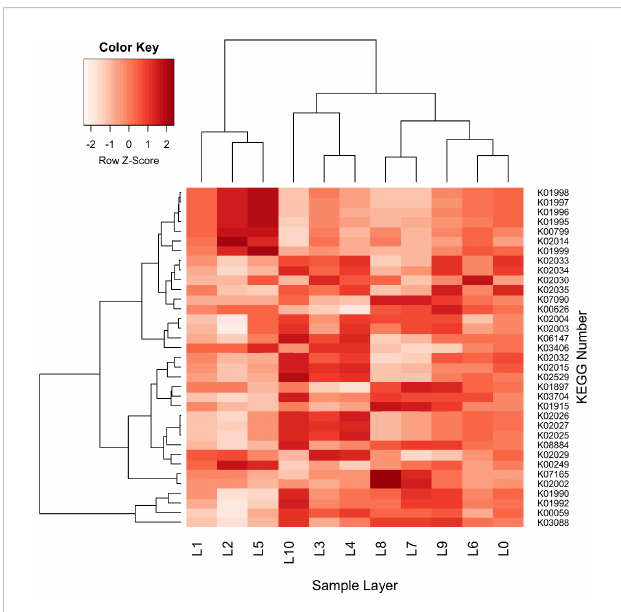
FIGURE 6 Heatmap showing most abundant likely KEGG numbered proteins associated with samples as inferred using PICRUSt. Soil layers are clustered into three groups: cluster 1, cluster 2 and cluster 3.